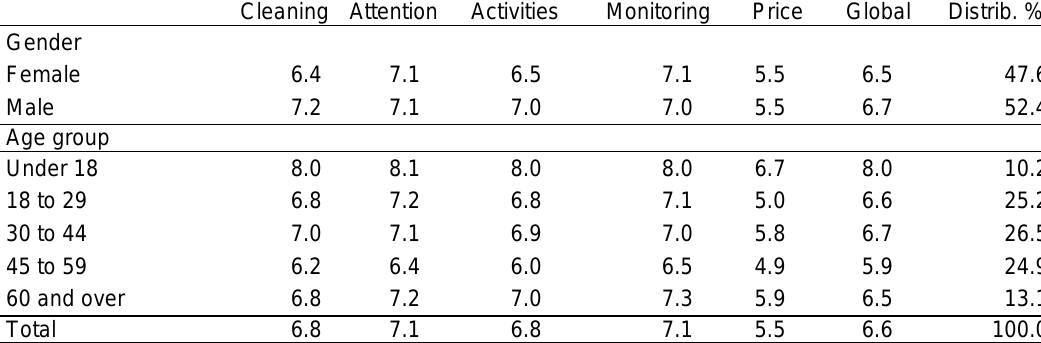
Table 15. Assessment of sports facilities by gender and age group (2017). Sanfeliu sports facility. Cleaning Attention Activities Monitoring Price Global Distrib. %